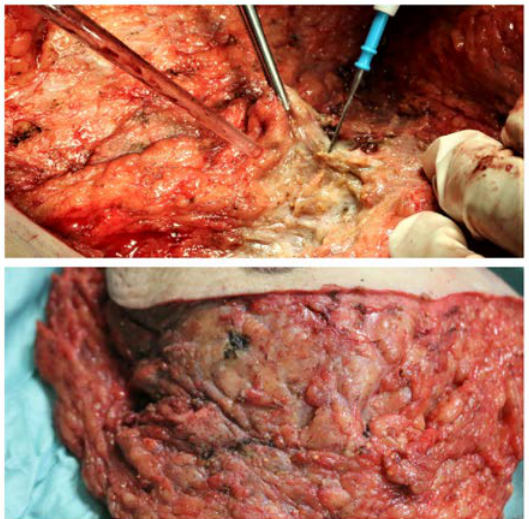
Figure 3. Intraoperative findings: ( Above ) The mass was deeply attached to the pectoralis major muscle fascia, and so it was difficult to identify a clean cleavage plan. An atypical appearance of mammary glands, partially indistinguishable from fat tissue, resulting in a single tough, dense mass with several small (<1 cm) orange calcified concretions, and fat necrosis areas. ( Below ) An atypical appearance of mammary glands, partially indistinguishable from fat tissue, resulting in a single dense mass with small orange calcified concretions, and fat necrosis areas as well.